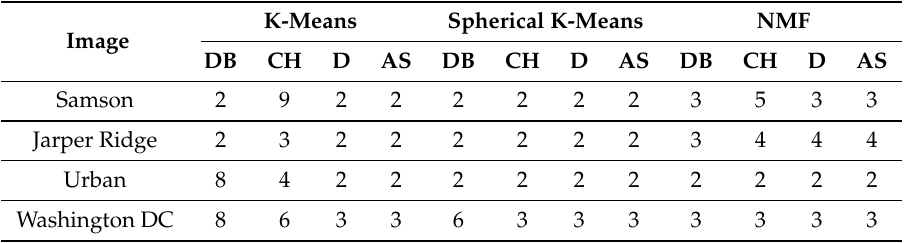
Table 5. Estimated number of endmembers using three clustering algorithms (K-means, Spherical K-means, and NMF) and four validation indexes (DB: Davies-Bouldin, CH: Calinski-Harabasz; D: Dunn, AS: average Silhouette) in each test